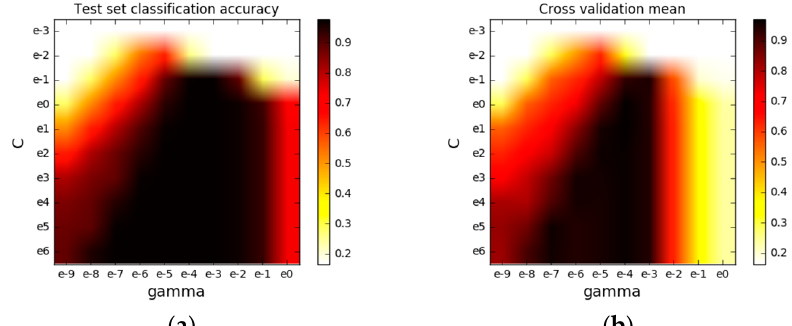
Figure 12. Selection of parameters C and σ in multiple classification: ( a ) Test set classification accuracy; ( b ) Cross validation mean.